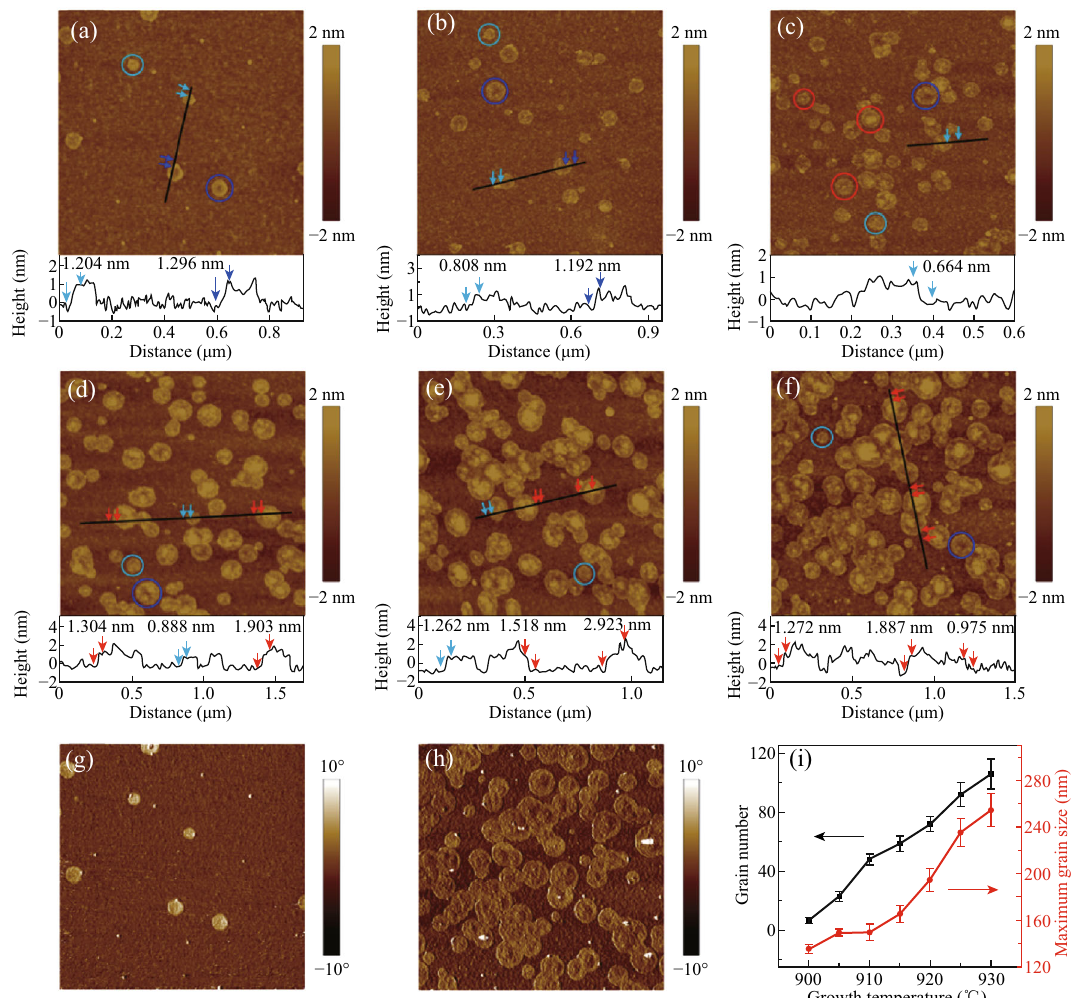
Fig. 3 Investigation of graphene nucleation and growth on silicon (100). a – f AFM height image of graphene domains directly grown on silicon (100) substrates for 1 h at the following temperatures: a 900 (cid:3) C, b 905 (cid:3) C, c 915 (cid:3) C, d 920 (cid:3) C, e 925 (cid:3) C, and f 930 (cid:3) C. The bottom row shows the corresponding height profile along the black line. The arrows indicate the height differences between the corresponding two points. Light blue, blue, and red circles correspond to flat, concave, and bulging graphene domains, respectively. The scan size is 2 l m. g , h The corresponding AFM phase images of graphene grown at 900 and 930 (cid:3) C, respectively. i The average grain number and the maximum grain size as a function of growth